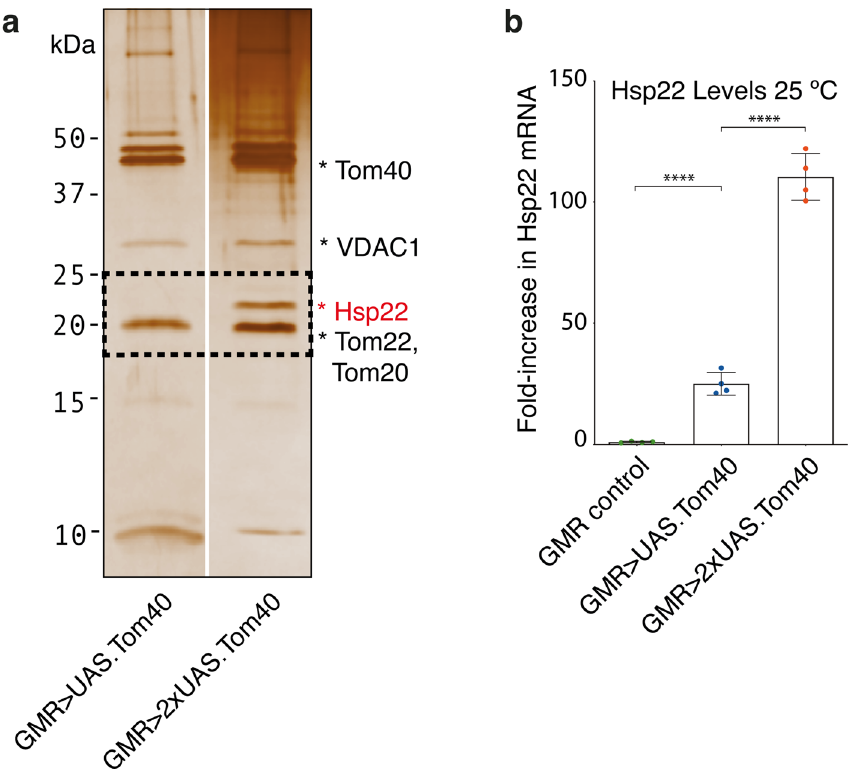
Figure 5. Dm Hsp22 is upregulated in a dose-dependent manner and associates with Tom40. ( a ) Silver-stained 15% SDS-PAGE showing affinity-purified (anti-FLAG) Tom40 samples from eye membranes solubilised with digitonin. Each sample corresponds to protein derived from ~ 800 fly heads and is representative of at least 3 independent samples. Affinity purified products from flies reared at 25 °C, carrying one (lane 1) or two (lane 2) copies of the UAS.Tom40 transgene. The boxed area highlights Hsp22. ( b ) Quantification of Dm Hsp22 mRNA in flies expressing 0, 1 or 2 copies of UAS.Tom40 at 25